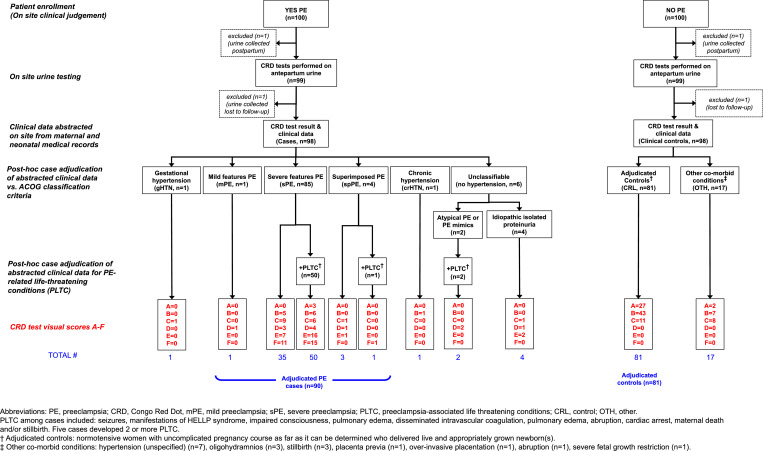
Study flowchart: Bangladesh.